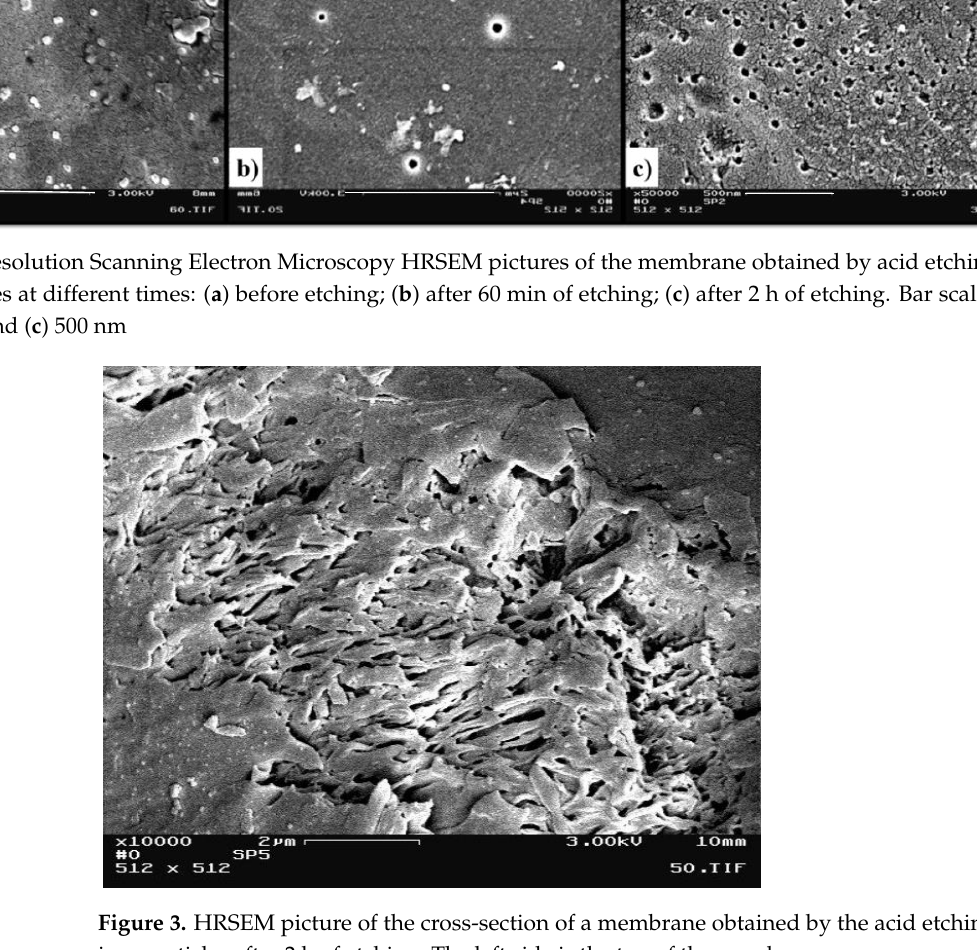
Figure 2. High Resolution Scanning Electron Microscopy HRSEM pictures of the membrane obtained by acid etching of nano iron particles at different times: ( a ) before etching; ( b ) after 60 min of etching; ( c ) after 2 h of etching. Bar scale: ( a ) 2 µm, ( b ) 2 µm, and ( c ) 500 nm